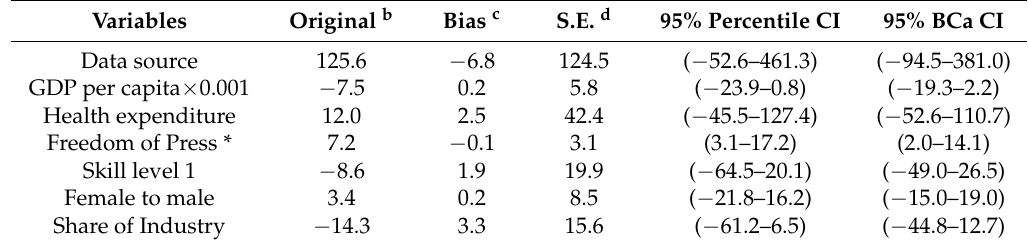
Table 2. The summary of regression coefficients and 95% confidence interval based on the bootstrap a .